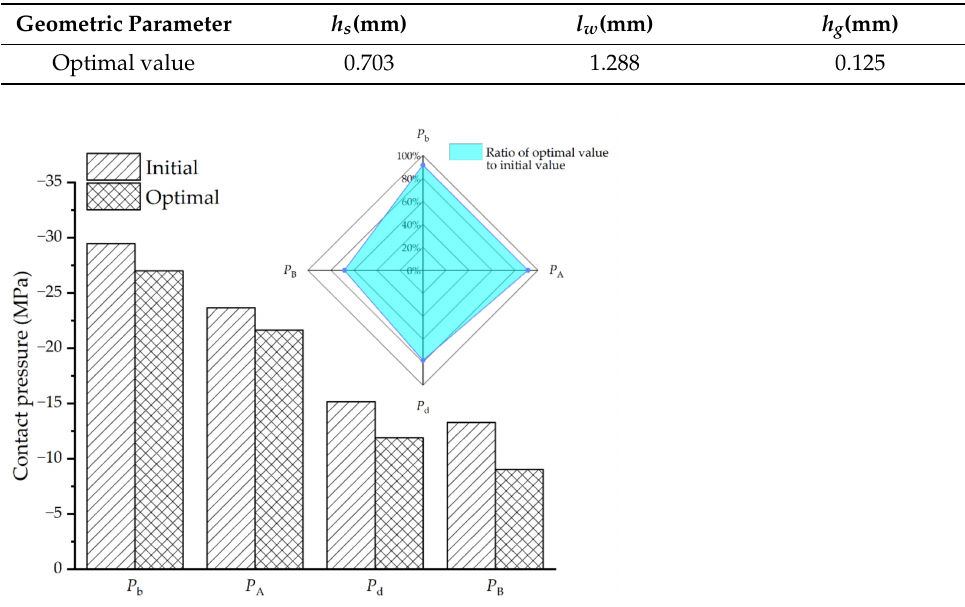
Table 6. Optimum geometric parameter of the solder joint.